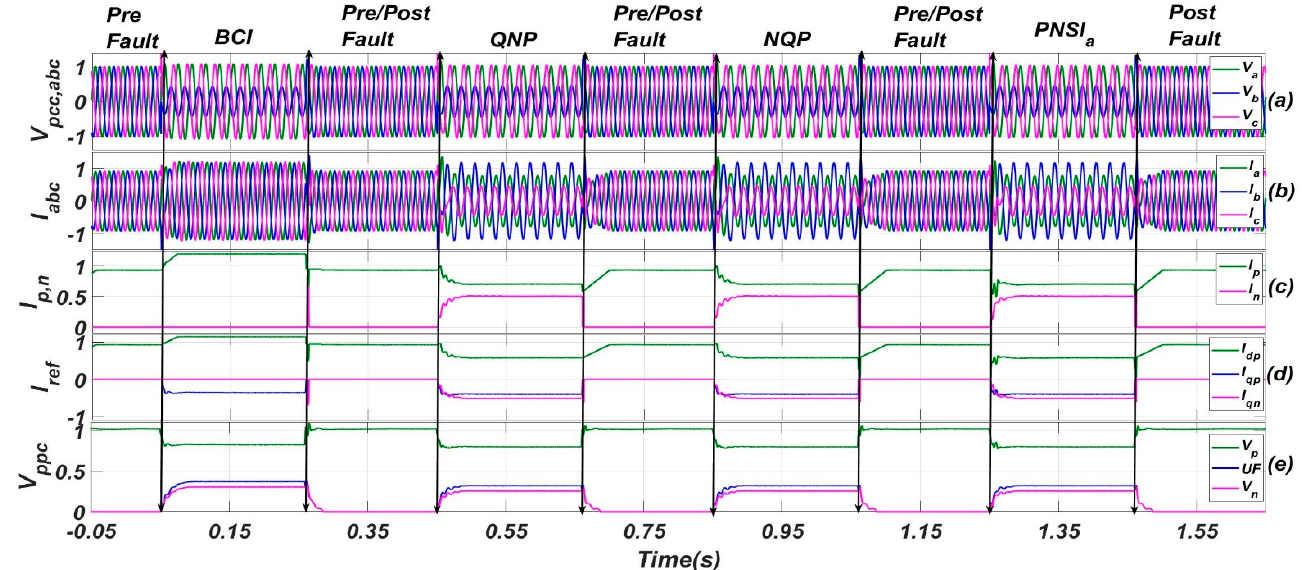
Figure 10. Performance comparison of different schemes for SLG Fault. ( a ) instantaneous three phase voltages (phase to neutral) at PCC, ( b ) instantaneous three phase converter’s currents, ( c ) magnitude of positive and negative sequence current phasor, ( d ) reference current components for positive and negative sequences, ( e ) magnitude of positive and negative sequence voltage phasor along with unbalanced factor.